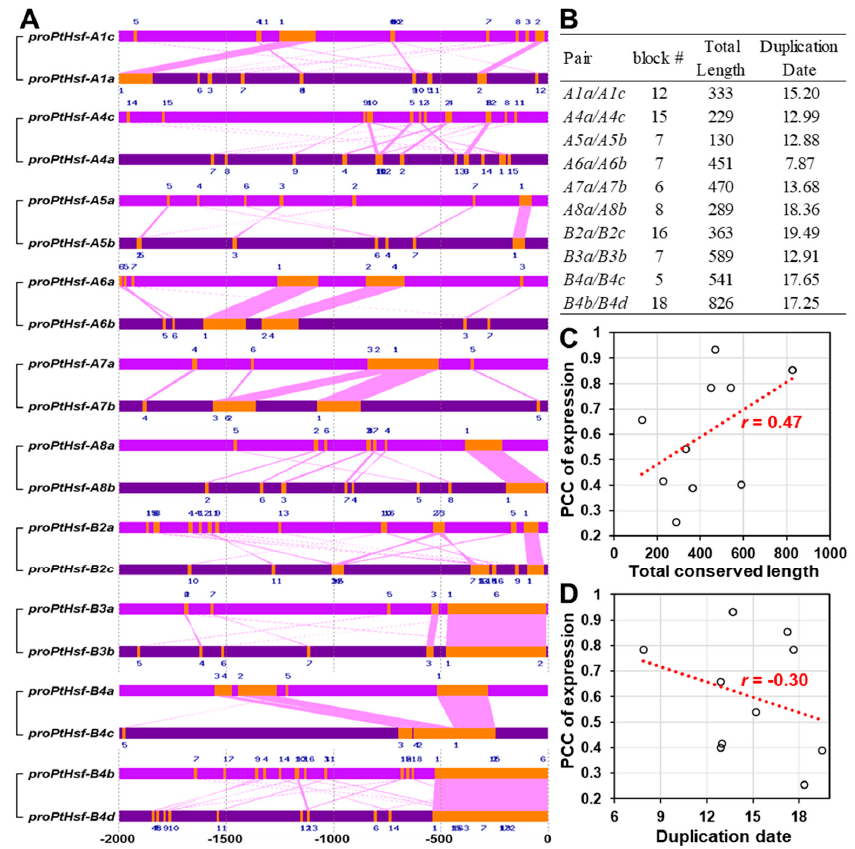
Figure 3. The promoter similarity between 10 gene pairs in the PtHsf family. ( A ) Conserved blocks located in the promoter region of PtHsf gene pairs. ( B ) Conserved block number and total conserved length between the PtHsf pairs’ promoter. ( C ) The correlation coefficiency between the total conserved length and the PCC of the expression (Figure 2) of PtHsf pairs. ( D ) The correlation coefficiency between the paralogous pair duplication date and the PCC of expression.